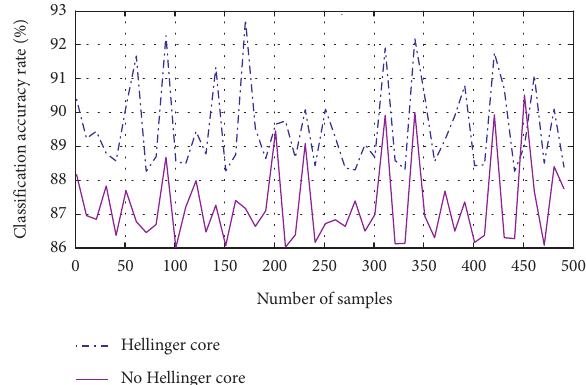
Figure 5: The influence of the Hellinger core on “descriptive child aggregation.”